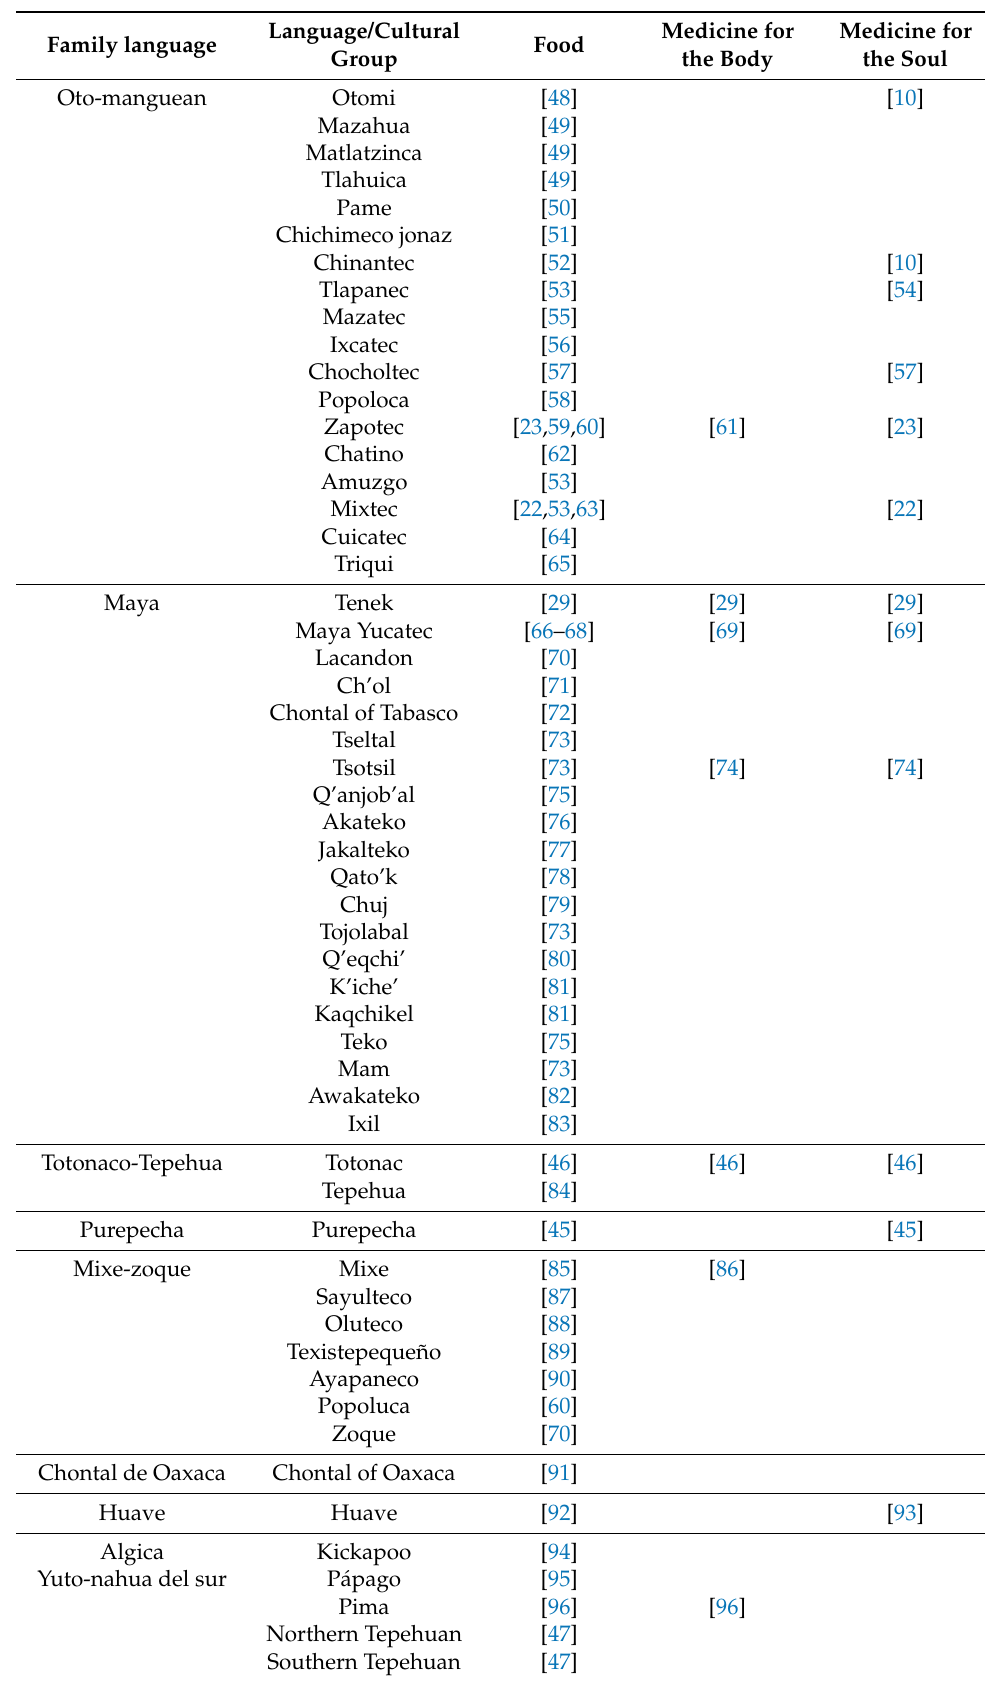
Table 1. Use of chile as food, medicine for the body and the soul in